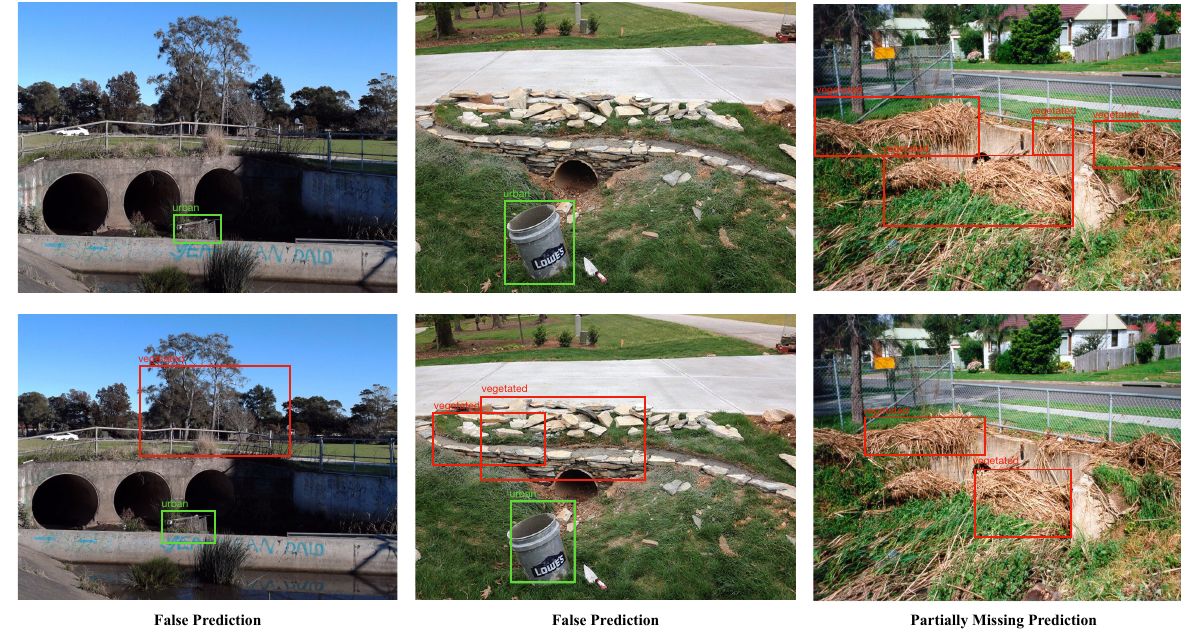
Figure 8. Sample of False Predictions by the Faster R-CNN with MobileNet Backbone